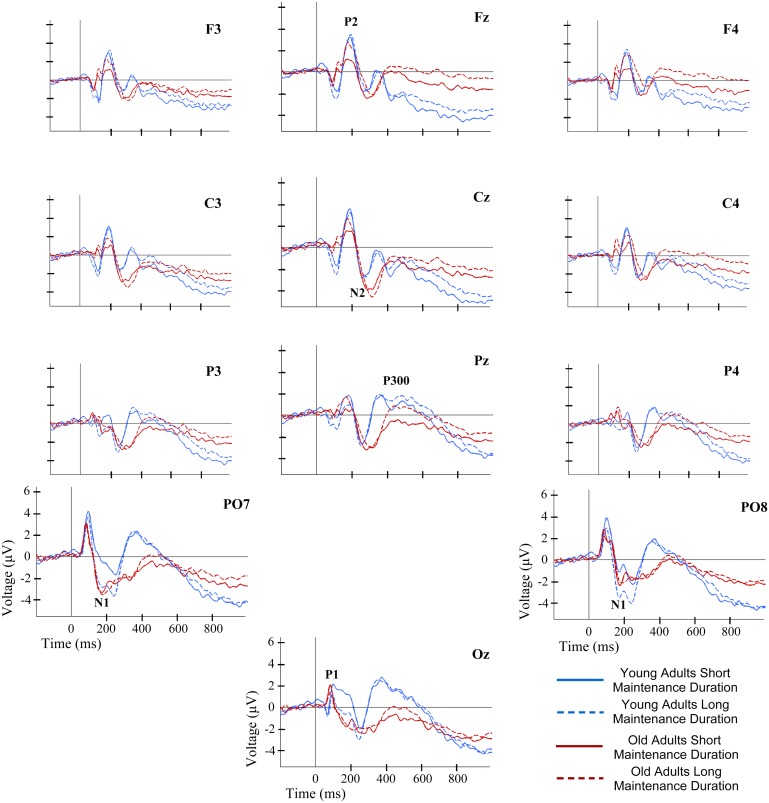
ERP waveforms at several electrode locations during recognition of information in WM.ERP waveforms for each group and maintenance duration condition.